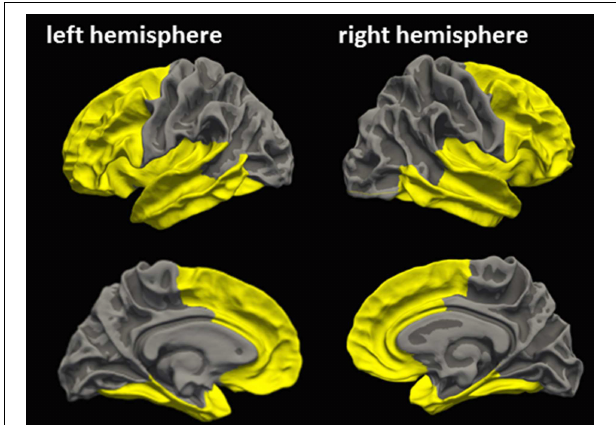
FIGURE 1 | A priori cortical ROI covering frontotemporal cortical regions most susceptible to mTBI. Yellow clusters indicate the a priori cortical ROI, which was defined based on FreeSurfer standard labels according to Ling et al. (2013), in order to cover cortical areas most susceptible to mTBI (Bigler and Maxwell, 2012). This frontotemporal ROI comprises the rostral and caudal anterior cingulate area, entorhinal area, insula, superior frontal area, caudal middlefrontal area, pars opercularis, inferior temporal area, lateral orbitofrontal area, medial orbitofrontal area, middle temporal area, pars orbitalis, pars triangularis, rostral middle frontal area, superior temporal area, frontal pole, and temporal pole, fusiform, parahippocampal, transversetemporal of each